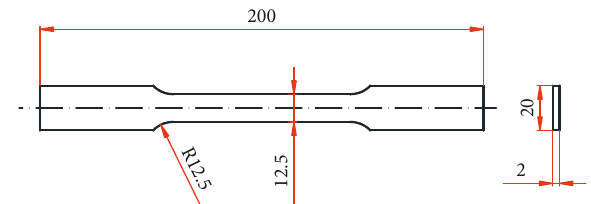
Figure 1: Geometric configurations of the tensile test specimen (unit: mm).